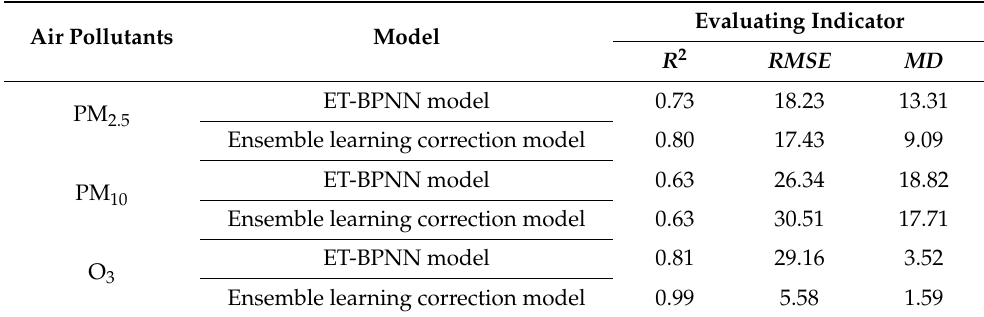
Table 7. Comparisons of Ensemble learning correction model and ET-BPNN